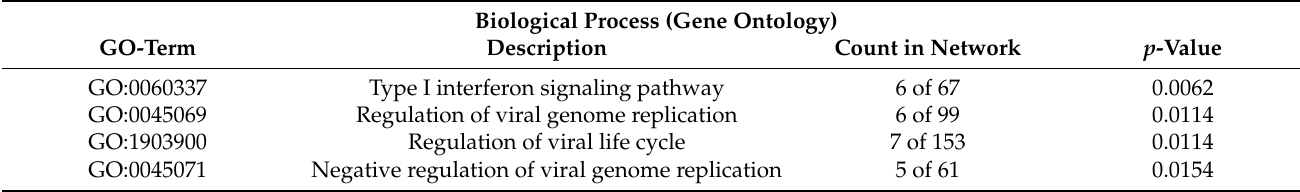
Table 5. Results of gene ontology (GO) analysis in biological processes (Tomatidine vs. Control). Biological Process (Gene Ontology)